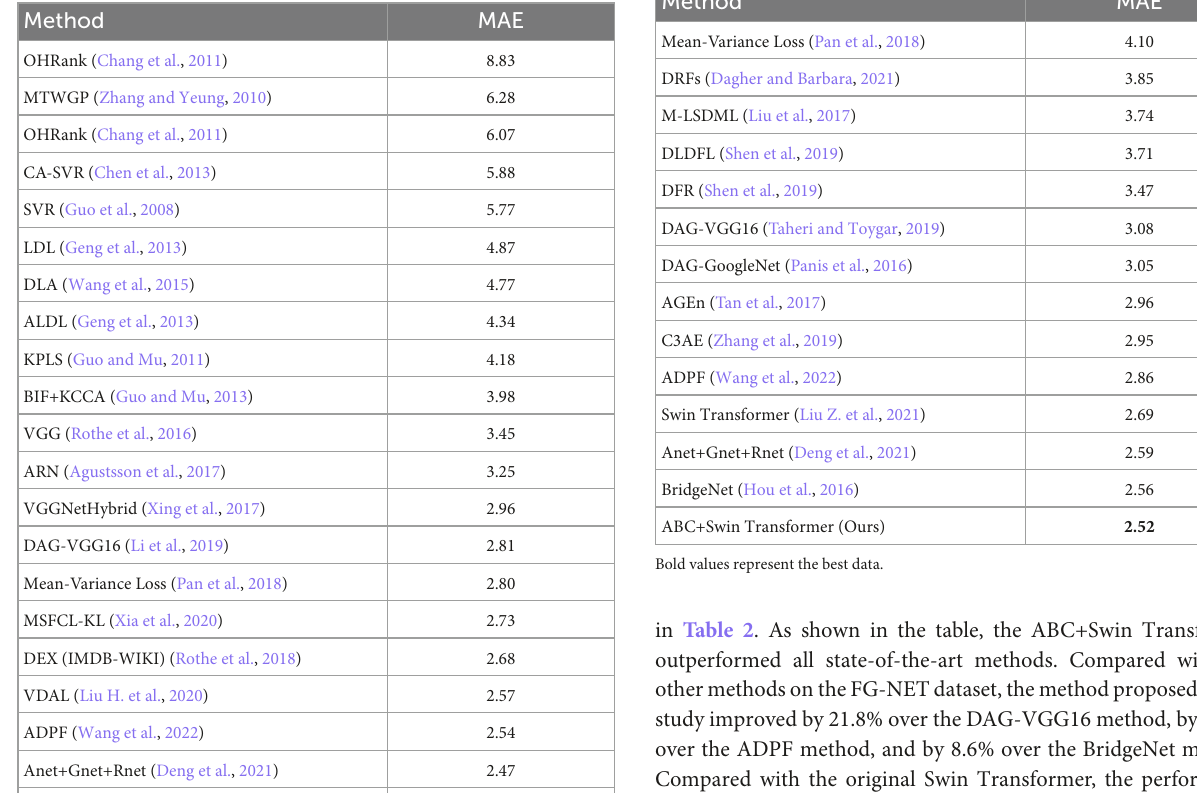
TABLE 2 Comparison of age estimates on the FG-NET dataset.